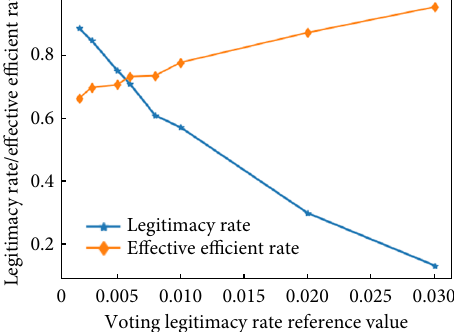
Fig. 15 Relationship of the number of the voting legitimacy rate reference